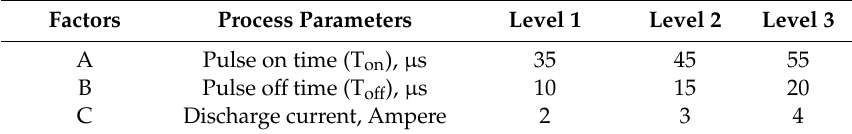
Table 3. Process parameters and their levels.